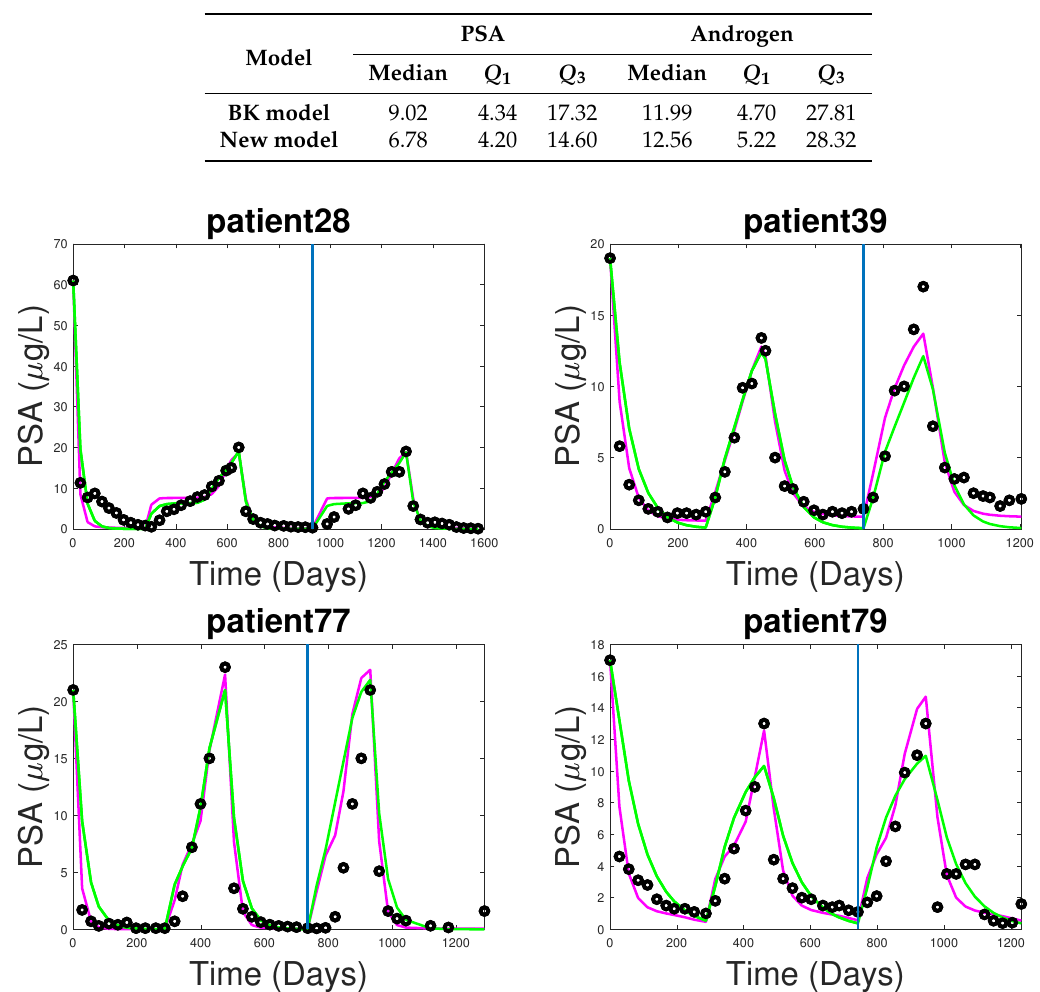
Table 4. Forecasting mean squared error (MSE) comparison (median, 1st quartile, 3rd quartile). Two models are compared, using 26 patient’s data. The new model demonstrates a slightly better forecasting ability, compared to the BK model. Furthermore, the forecasting ability of model 2 has been shown to be superior, among existing work under different metrics [8,18]. Additionally, the forecasting of androgen is comparable between the two models.